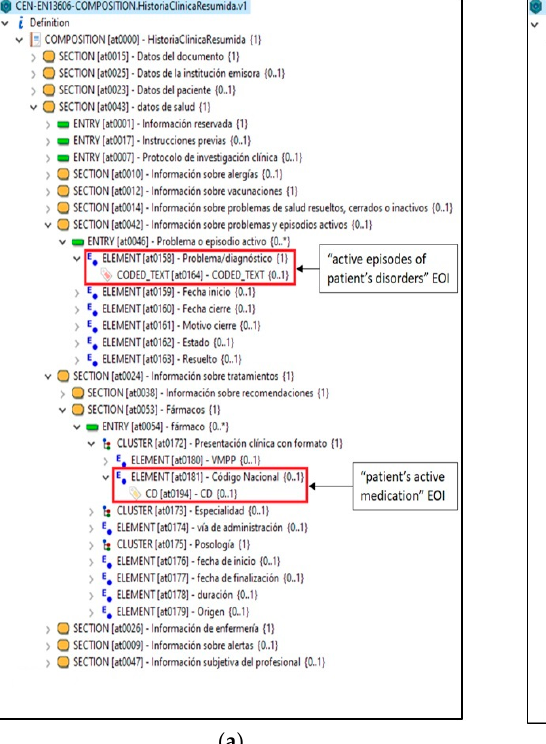
Figure 12. Augmentation archetypes’ visualization from LinkEHR. ( a ) The CEN ‐ EN13606 ‐ CLUSTER. DrugDrugInterac ‐ tion.v1 augmentation archetype for the drug–drug interactions EHR augmentation. ( b ) The CEN ‐ EN13606 ‐ CLUSTER.Dis ‐ easeTreatment.v1 augmentation archetype for the disease ‐ related treatments’ EHR augmentation.